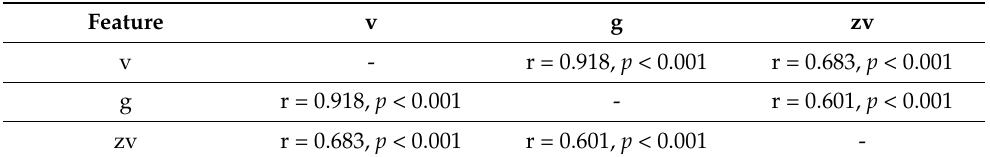
Table 1. Results of the correlation of Spearman ranks, features characterizing wood resources (the relationship was considered significant at p ≤